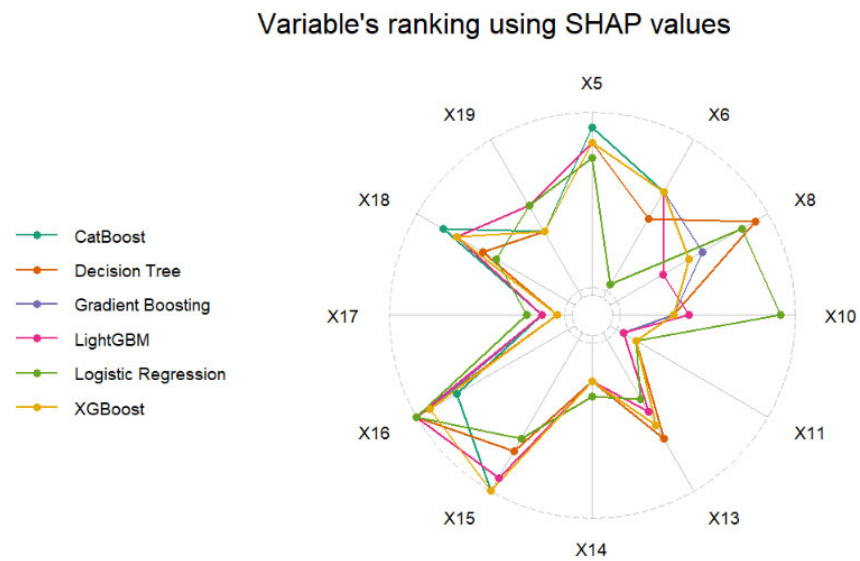
Figure 5. Feature importance ranking by SHAP value per supervised learning algorithms used.